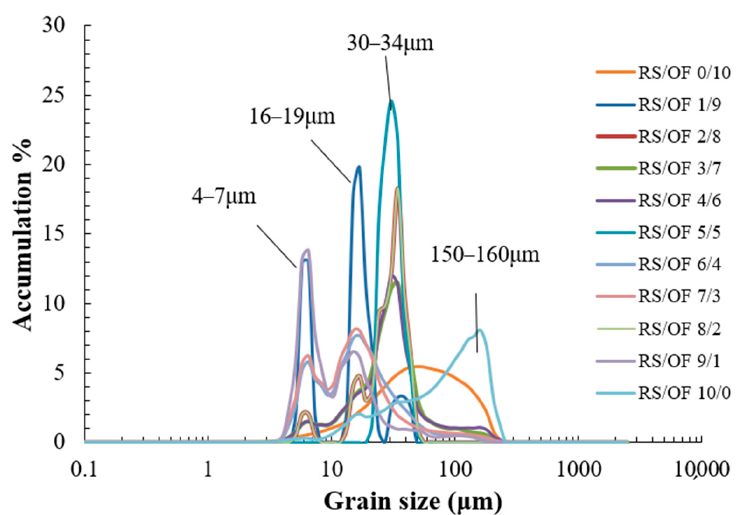
Figure 2. Particle size distribution of rice starch (RS) and oat flour (OF) mixture